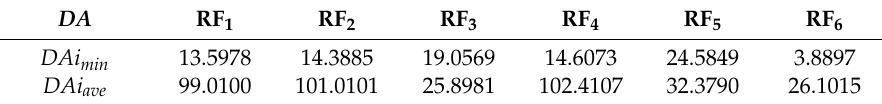
Table 9. The DAi(min) and DAi(ave) based on the